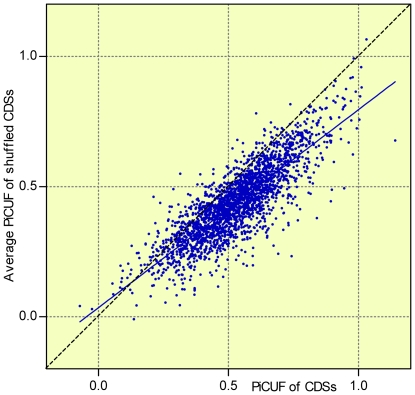
PiCUF of M. tuberculosis CDSs versus PiCUF of shuffled CDSs.Scatter plot of the PiCUF of M. tuberculosis CDSs versus the average of 5000 PiCUF values obtained by shuffling their codons. The solid line represents the linear regression line and the broken line corresponds to equal values on both axes.